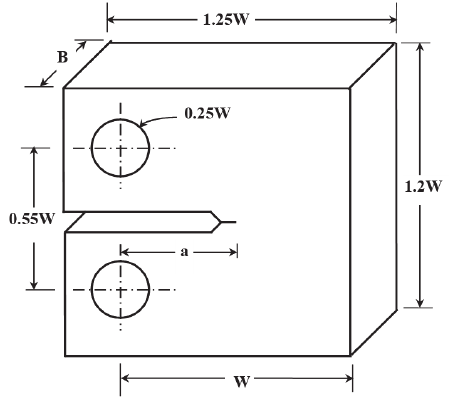
Figure 1: The geometry of the CT specimen used in the analysis (W=20